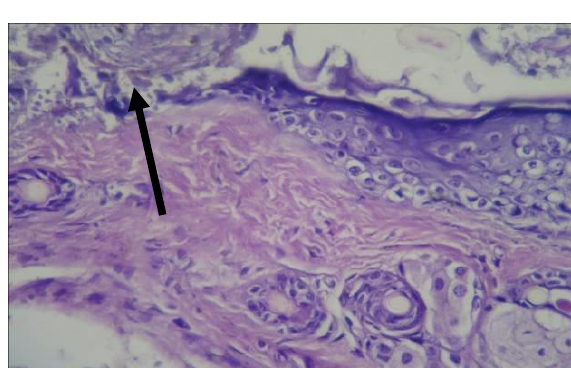
Figure,4: Section in the skin of infected non- immunized animal at day 14 post challenge showed epidermal hyperkeratosis and acanthosis (H&E stain